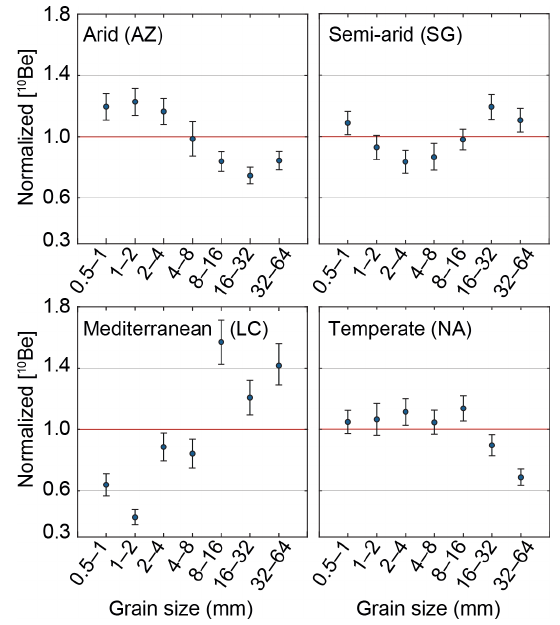
Figure 5. Normalized 10 Be concentrations ( ± 2 σ analytical error) measured in seven different grain size classes. The 10 Be concentra- tions are normalized to the arithmetic mean of all grain size frac- tions within a catchment. The red line indicates the normalized catchment-average 10 Be